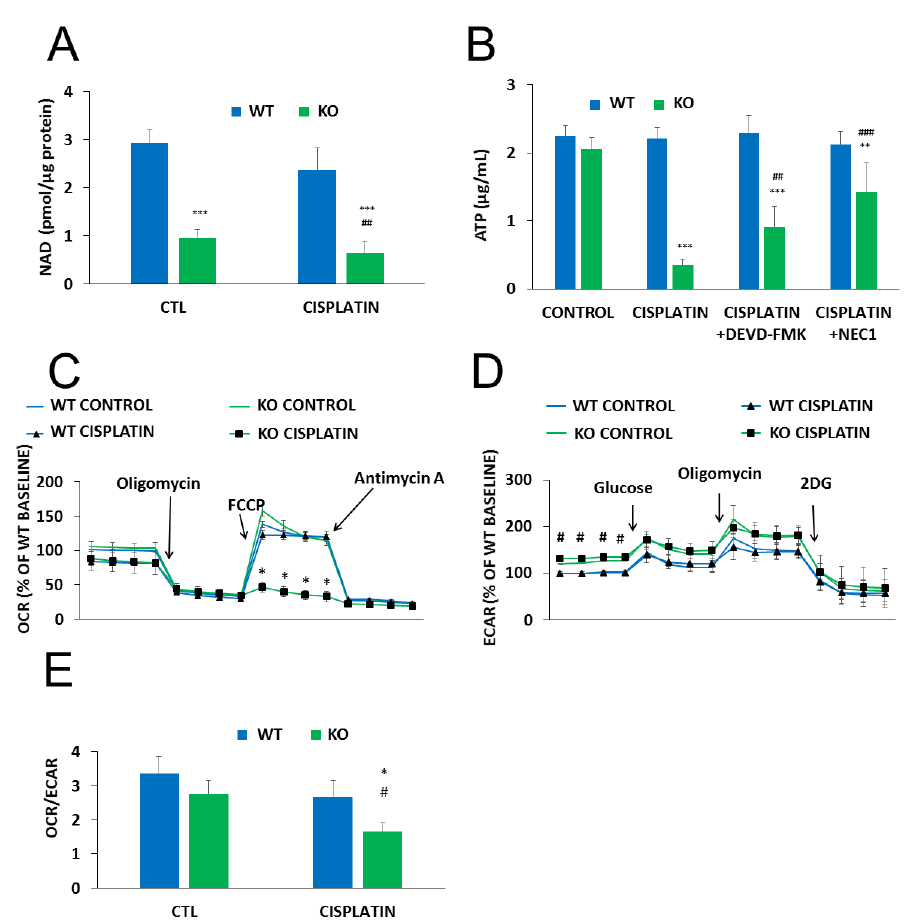
Figure 4. Metabolic alterations in NMNAT-1 KO cell line. Following cisplatin (5 µ g / mL) treatment (24 h), total NAD + levels were determined from cell lysates of WT and KO cells and normalized to protein content. Bars marked with asterisks are significantly di ff erent from the control (Bonferroni test; *** p < 0.001). Data points marked with hashmarks are significantly di ff erent from the corresponding treatment of the wild type cells (Bonferroni test; ## p < 0.01) ( A ). Cellular ATP was assayed 24 h after cisplatin treatment ( B ). Cells were treated with cisplatin alone or in combination with apoptosis (z-DEVD-FMK, 100 µ M) or necroptosis (NEC1, 30 µ M) inhibitors. Inhibitors were added 30 minutes before cisplatin treatment. Bars marked with asterisks are significantly di ff erent from the control (not shown) (Dunnett test; ** p < 0.01, *** p < 0.001). Bars marked with hashmarks are significantly di ff erent from the cisplatin-treated samples (Dunnett test; ## p < 0.01, ### p < 0.001). ( B ). Oxygen consumption rate (OCR) / oxidative phosphorylation ( C ) and extracellular acidification rate (ECAR) / glycolytic activity ( D ) were determined using a Seahorse metabolic analyzer and expressed as a percentage of the WT baseline. Both OCR / oxidative phosphorylation and ECAR / glycolytic activity were monitored in specific stress tests 13 h after cisplatin treatment. Mitochondrial stress tests included oligomycin (2 µ M), FCCP (0.5 µ M), and antimycin A (1 µ M) for OCR ( C ) and glucose (10 mM), oligomycin (2 µ M) and 2-deoxyglucose (50 mM) for ECAR ( D ). Data points marked with asterisks are significantly di ff erent from the corresponding vehicle treated data points at the same phase of the graph (Student–Newman–Keuls method; * p < 0.05). Data points marked with hashmarks are significantly di ff erent from the corresponding data points of wild type cells at the same phase of the graph (Student-Newman-Keuls method; # p < 0.05). Ratios of the two metabolic routes were determined from the baseline OCR and ECAR values 13 hours after cisplatin treatment. Bars marked with asterisks are significantly di ff erent from the corresponding vehicle treated group (Student-Newman-Keuls method; * p < 0.05). Bars marked with hashmarks are significantly di ff erent from the corresponding group of wild type cells (Student-Newman-Keuls method; # p < 0.05) ( E ). Data plotted are means ± SEM ( n =